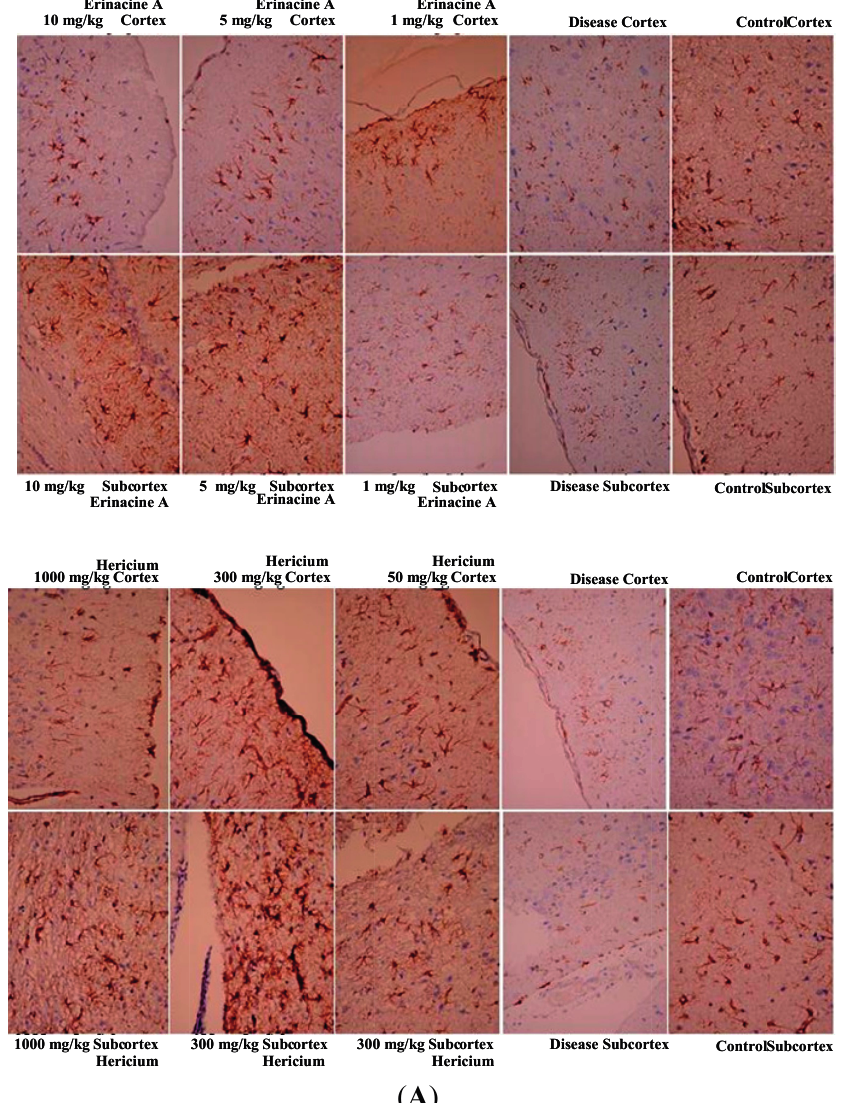
Figure 3. Effect of Hericium erinaceus mycelium (HEM) on brain histological examination in transient stroke animal model. Rats were treated without (control group, CL) or with H. erinaceus mycelium by oral HEM administration (50, 300, 1000 mg/kg) and i.p. erinacine A injection (1, 5, 10 mg/kg). Histological examination of the brain revealed cortex and subcortex zones as indicated by immunohistochemical staining of NeuN. ( A ) Rats were sacrificed and the brains were separated. Representative brain sections stained as: the control group; rats with transient SAM; HEM treatment (50, 300, 1000 mg/kg) staining of brain tissue. Erinacine A treatment (1, 5, 10 mg/kg) staining; ( B ) Evaluation of pathological examination and NeuN expression were quantitative in brain tissue. The cells were counted from 10 fields (200× magnification) of each brain sample. The results from statistical analysis are the means of cells and were calculated per microscope field from six animals per group. Data are expressed as the mean ± SD of independent experiments. n = 6. * p < 0.05, SAM group versus SAM + HEM group. # p < 0.05, SAM group versus SAM + erinacine A